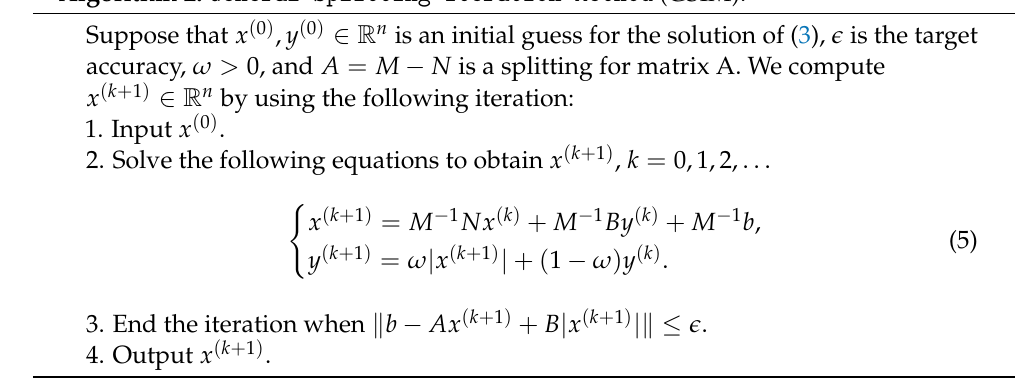
Algorithm 2: General Splitting Iteration Method